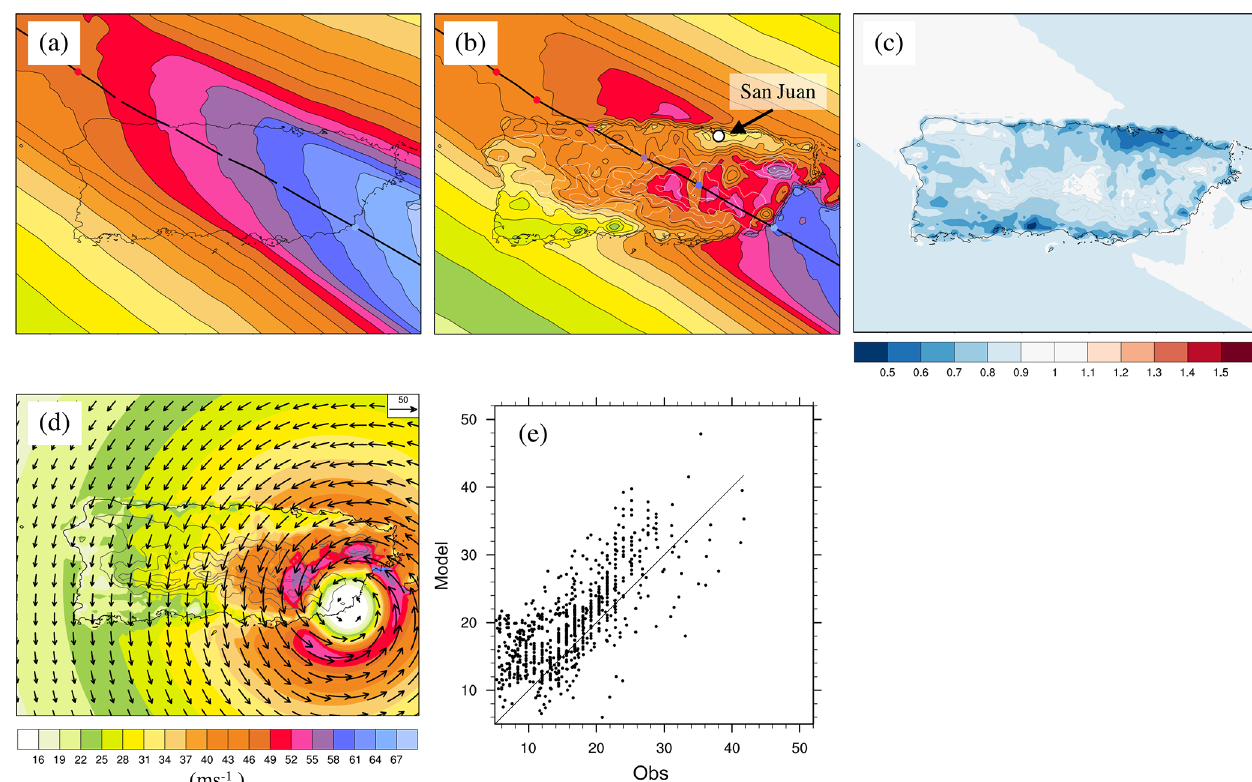
Figure 2. Case study simulation of Hurricane Maria (2017) over Puerto Rico. Simulated footprints (ms − 1 ) are shown using (a) Willoughby only and (b) Willoughby and KW01. The hurricane track is shown by the thick black line with input V max shown every 6h along the track (coloured dots). Coastlines are shown by the thin black lines and are only included in panel (a) to aid interpretation. (c) The ratio of Willoughby and KW01 to Willoughby only. (d) A snapshot of the simulation using Willoughby and KW01 at the time of landfall (wind speed is contoured and wind vectors are shown in arrows). Terrain height is contoured every 200m in panels (b) – (d) . (e) A comparison of observed and simulated (Willoughby and KW01)